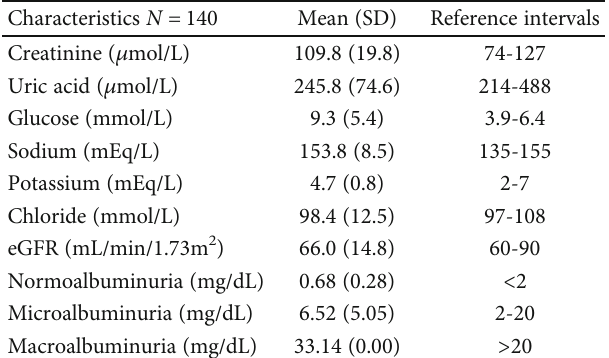
Table 1: Sociodemographic characteristics of participants. Table 2: Laboratory renal markers of the study population.